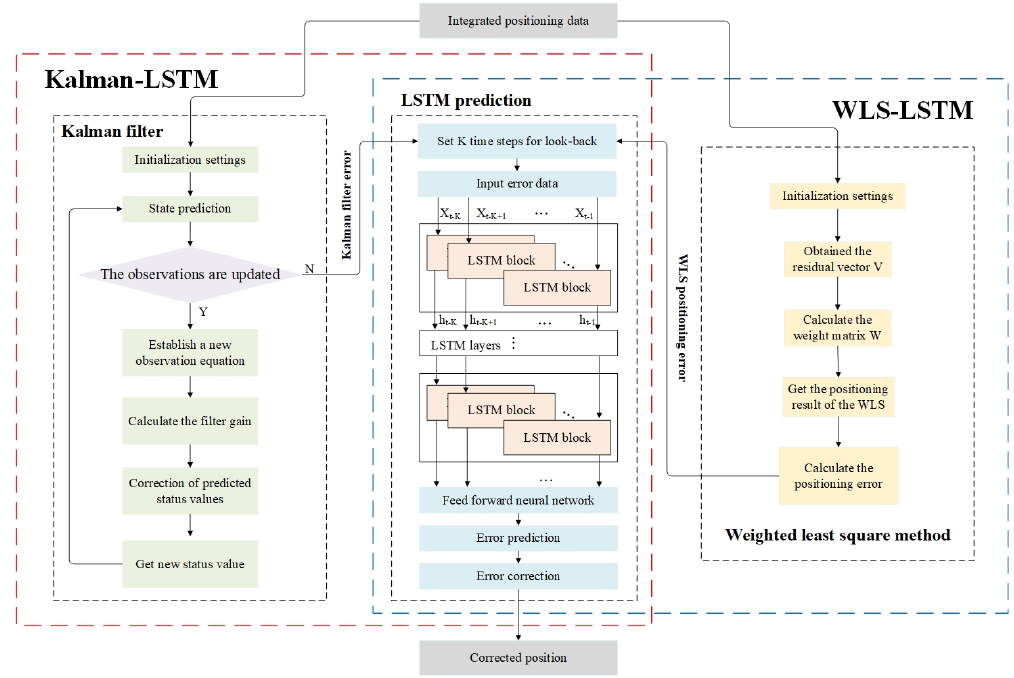
Figure 4. The LSTM-based error correction framework.